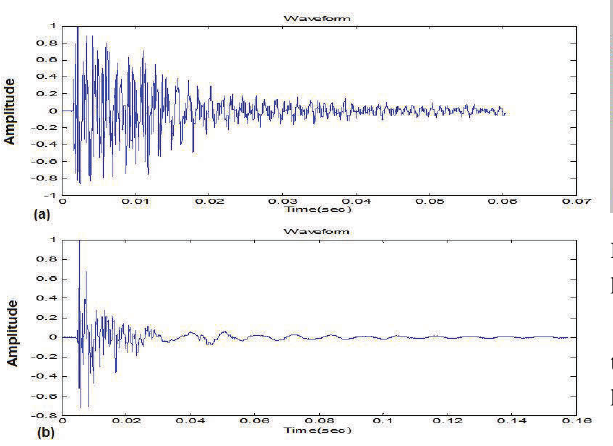
Figure 2. Free-decay response of dry plate (a) and wet plate (b).